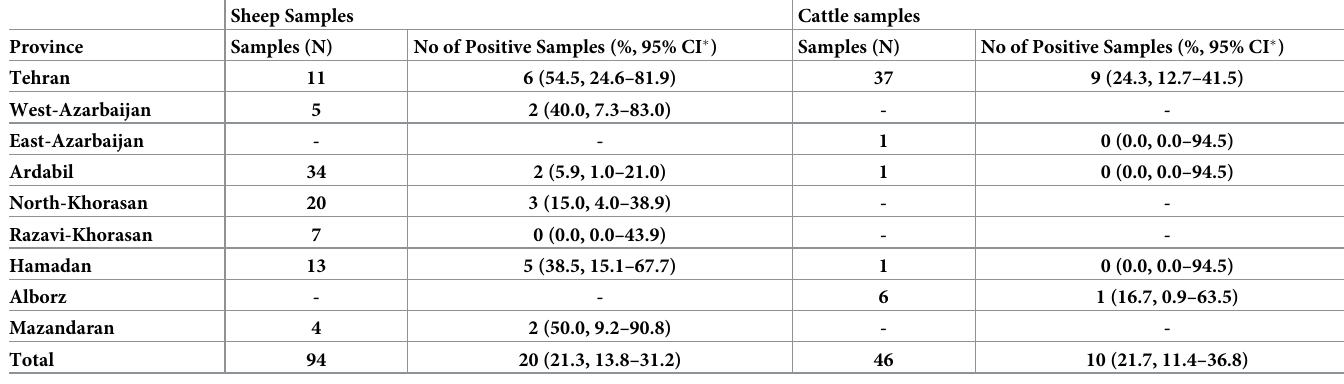
Table 1. The prevalence of C . burnetii in sheep and cattle abortion samples by Real-time PCR in Iran during 2017–2018. Sheep